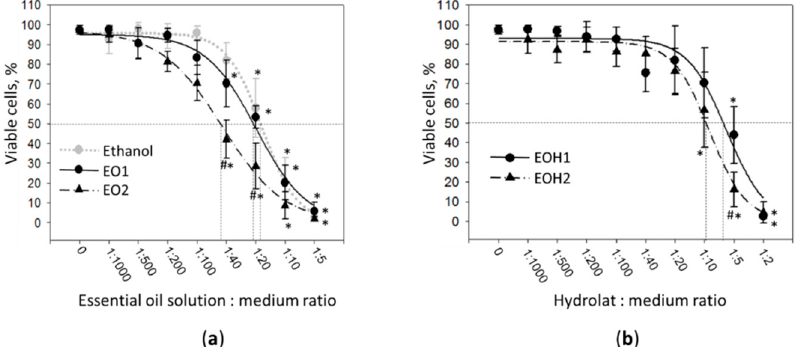
Figure 1. The e ff ect of nutmeg essential oil ethanol solutions ( a ) and nutmeg essential oil hydrolats ( b ) on viability of cultured human fibroblasts. EO1—essential oil without excipient solution, EO2—essential oil with 1% magnesium aluminometasilicate solution, EOH1—hydrolat from EO1, and EOH2—hydrolat from EO2. In addition, 96% ethanol was assessed as solvent control for the essential oil. Punctured lines indicate the dilution ratios corresponding to LD 50 . *—statistically significant di ff erence compared to untreated control, #—compared to EO1 in ( a ) or EOH1 in ( b ), respectively, when p < 0.05.